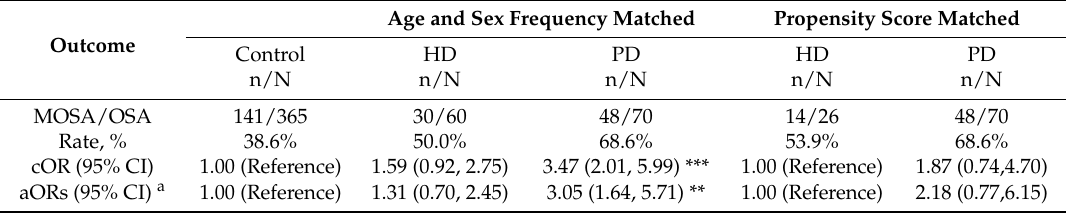
Table 4. The risk of MOSA under CPAP treatment with estimated odds ratio by logistic regression